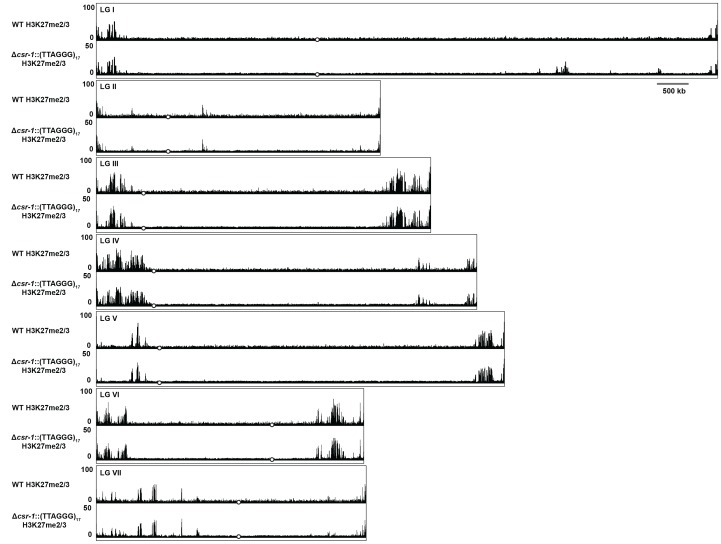
Whole genome view of H3K27me2/3 ChIP-seq in WT and Δcsr-1::(TTAGGG)17.H3K27me2/3 ChIP-seq for all seven N. crassa chromosomes is displayed for WT (pooled biological triplicates) and Δcsr-1::(TTAGGG)17 (single sample). The y-axis is number of reads averaged over 25 bp windows. Open black circles indicate location of centromeres.